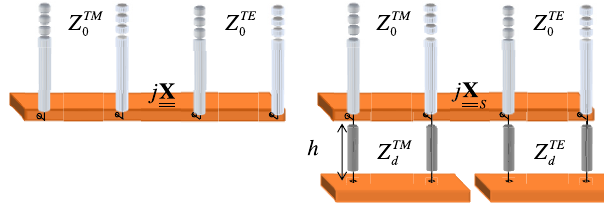
Fig. 2. Equivalent transmission line models for the IIBC (left) and the